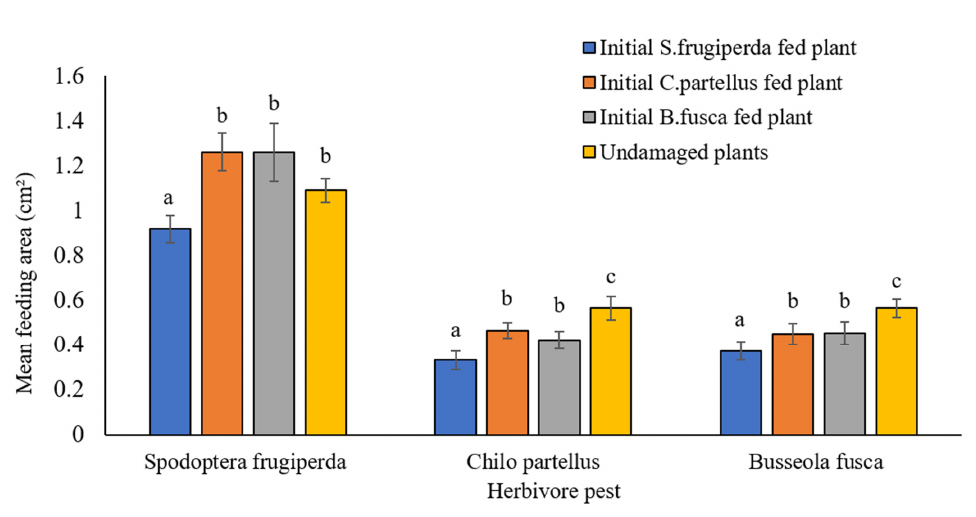
Figure 1. Competitive plant-mediated interactions on larval maize leaf feeding rate of Spodoptera frugiperda , Chilo partellus , and Busseola fusca on initially herbivore-damaged and undamaged plants. Different letters above clustered columns indicate statistically significant differences in larval feed- ing on herbivore-damaged and undamaged plants (one-way ANOVA; p < 0.05). Experiment 2: Effects of herbivore-damaged leaves on larval development When 10 neonates of S. frugiperda were exposed together with either 10 neonates of B. fusca or C. partellus on maize plant and allowed to feed for 15 days, larval survival and growth and development of S. frugiperda neonates were undeterred. However, fitness in- dices of B. fusca and C. partellus neonates were significantly reduced (Table 1). Larval sur- vival rates, weight, and length of B. fusca neonates were significantly lower upon co-in- habitation with S. frugiperda on maize plant ( p < 0.001, p = 0.01, and p < 0.001 respectively). Similarly, larval survival rates, weight, and length of C. partellus neonates declined signif- icantly upon co-infestation with S. frugiperda on maize plant ( p < 0.001 for larval survival, weight, and length). Larval survival, weight, and length of S. frugiperda when co-existing with B. fusca were not significantly different compared to its infestation in maize alone ( p = 0.47, p = 0.75, and p = 0.60, respectively). Similarly, larval survival rates, weight, and length of S. frugiperda when co-existing with C. partellus did not change significantly com- pared to when it existed alone in maize plants ( p = 0.66, p = 0.91, and p = 0.66, respectively) (Table 1). We observed that the survival rates and larval growth parameters of B. fusca and C. Partellus larvae when co-inhabited on maize plants did not differ statistically. Sur- vival rate, larval weight, and length of B. fusca when co-existing with C. partellus was not statistically different ( p = 0.12, p = 0.17, and p = 0.19 respectively) (Table 1). Similarly, sur- vival rate, larval weight, and length of C. partellus when co-existing with B. fusca was not statistically different ( p = 0.12, p = 0.27, and p = 0.14 respectively) (Table 1). After 15 days of feeding on maize plant, the most occurring larval instar of the recovered larvae differed between S. frugiperda larvae and those of B. fusca and C. partellus . Most of the S. frugiperda larvae were at fourth instar whether co-inhabiting maize plant with conspecifics or inter- specific larvae. Conversely, most of the larvae of B. fusca and C. partellus were at second instar whether co-inhabiting maize plant with conspecifics or interspecific larvae (Table 1).